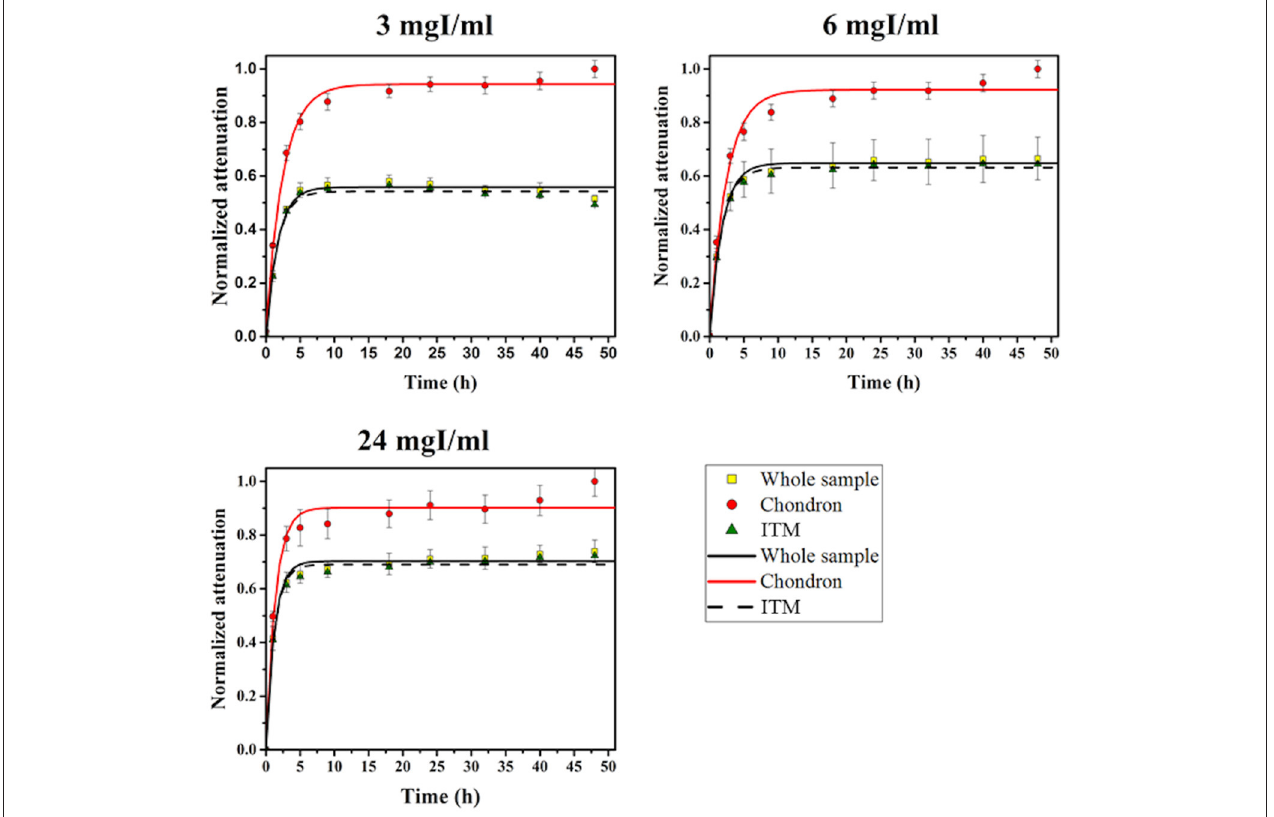
FIGURE 3 | Diffusion profiles fitted on Chondron segmented, ITM segmented and unsegmented (Whole sample) data. Datapoints present normalized and averaged x-ray attenuation values in CA4 + stained chondron areas (Chondron), interterritorial matrix (ITM) and in whole articular cartilage (Whole sample). Datapoints were averaged inside each CA4 + concentration group ( N = 3) and the standard deviation inside the group is presented as error bars in the plots. Equation (1) was used for the fits. Similarities of the diffusion profiles for the whole sample (both) and for the ITM can be observed.